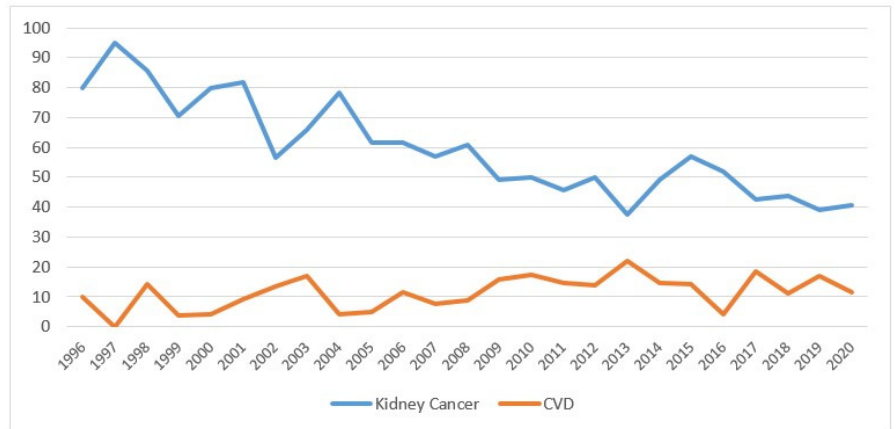
Figure 5. Percentage of deaths for kidney cancer and cardiovascular disease by year of death (the percentages are calculated on the total of deaths from all causes) in the Province of Reggio Emilia in the period 1996–2020.